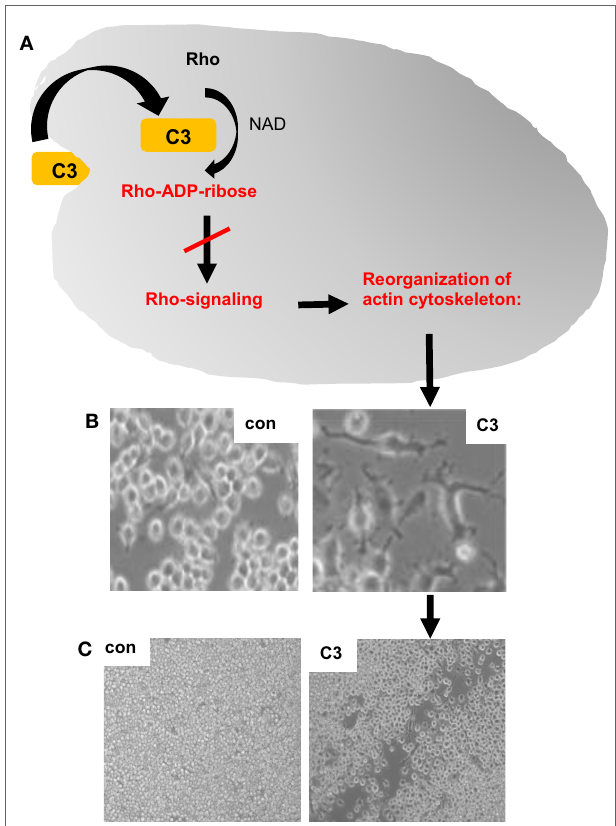
FiguRe 1 | effects of clostridial C3 toxin on macrophages . The uptake of clostridial C3 toxin into the cytosol of macrophages causes the C3-catalyzed ADP-ribosylation of Rho and inhibition of Rho signaling, which results in a reorganization of the actin cytoskeleton [schematically depicted in (A) ], a dramatic change of the cell morphology (B) and an inhibition of the migration of cultured macrophages, as shown by the scratch test experiment (C) . NAD, nicotinamide adenine dinucleotide; con, untreated J774A.1 macrophages, which were grown for 24 h after the removal of a portion of the cells by a scratch; C3, J774A.1 cells treated for 24 h with 300 nM C3bot1 after removal of some cells by a scratch. After treatment with C3bot1, the scratch remains open, indicating less macrophage migration of C3-treated macrophages compared to untreated control